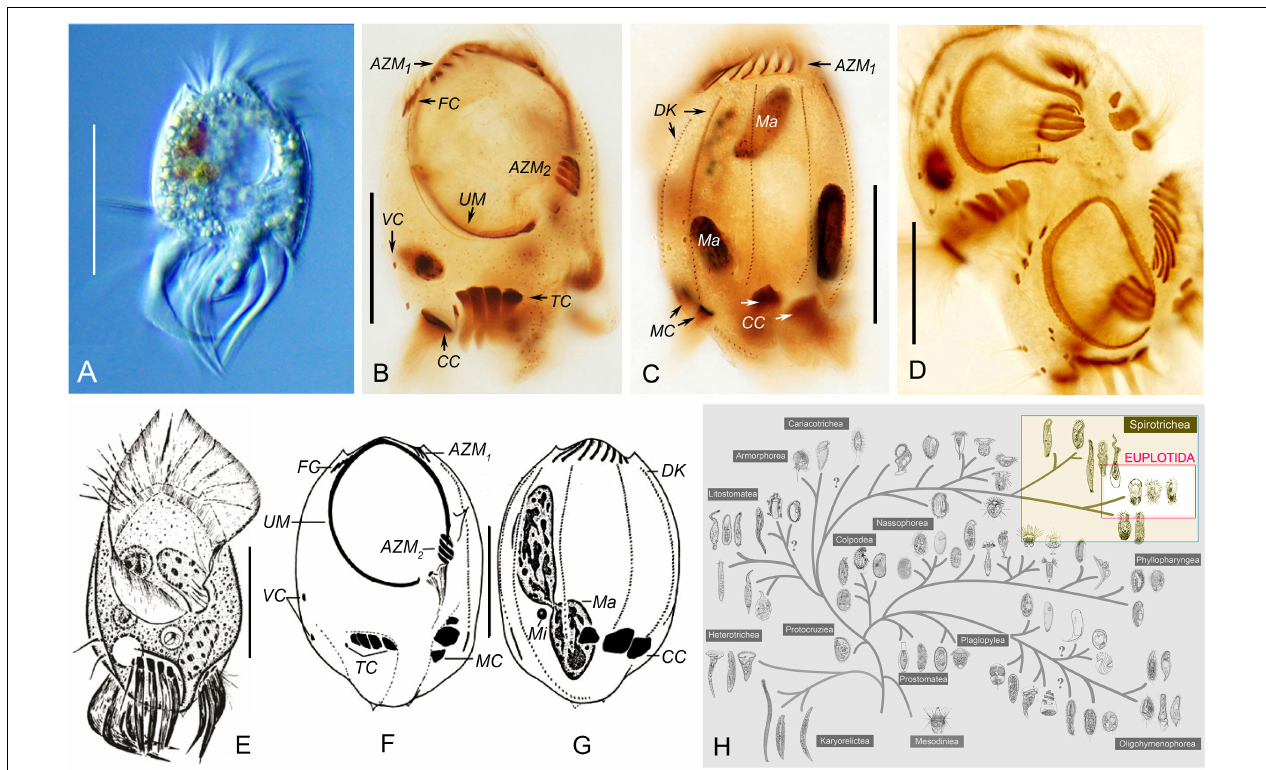
FIGURE 1 | Morphology, infraciliature and taxonomic position of Uronychia binucleata in vivo (A,E) and after protargol staining (B–D,F,G) . (A,E) Ventral views of representative individuals. (B,C,F,G) Ventral (B,F) and dorsal (C,G) views, showing nuclear apparatus and infraciliature. (E–G) were modified from Song et al. (2009). (D) Ventral view of a mid-stage divider. (H) Taxonomic positions of Uronychia binucleata and related taxa in the hypothetical evolutionary tree of ciliated protozoa according to Gao et al. (2016). Euplotida is highlighted. AZM 1 , 2 , adoral zone of membranelles 1, 2; CC, caudal cirri; DK, dorsal kineties; FC, frontal cirri; Ma, macronucleus; MC, marginal cirri; TC, transverse cirri; UM, undulating membrane; VC, ventral cirri. Scale bars = 50 µ